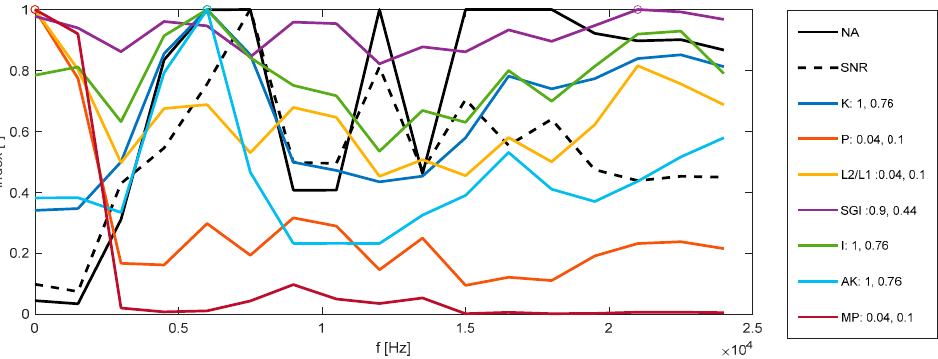
Figure 5. 176FE traditional band indicators as a function of the center frequency f , compared to the proposed NA and SNR a posteriori indicators. The maximum of each indicator is highlighted by a circle, and the value of NA and SNR at that point are reported in the legend. The average of such two values produces the iE , which is summarized in Table 3.